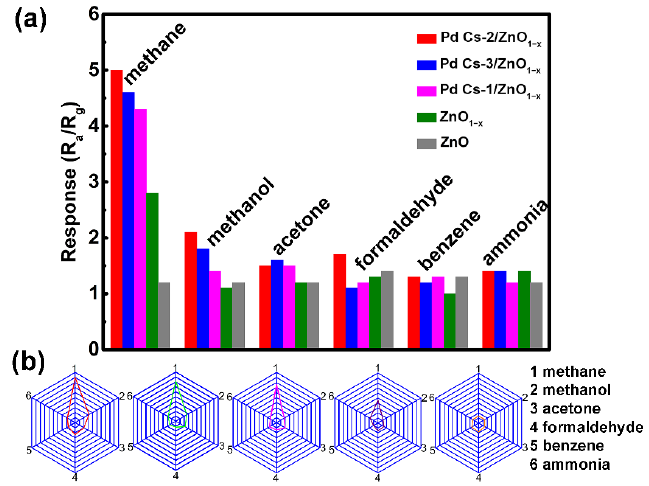
Figure 11. ( a ) Sensors’ selectivity: the representative responses of five different gas-sensing materials to different VOCs (50 ppm) at 260 °C, 40% RH. ( b ) Illustration of relative selectivity of five different sensors (Pd Cs-2/ZnO 1−x , Pd Cs-3/ZnO 1−x , Pd Cs-1/ZnO 1−x , ZnO 1−x , and ZnO, respectively).